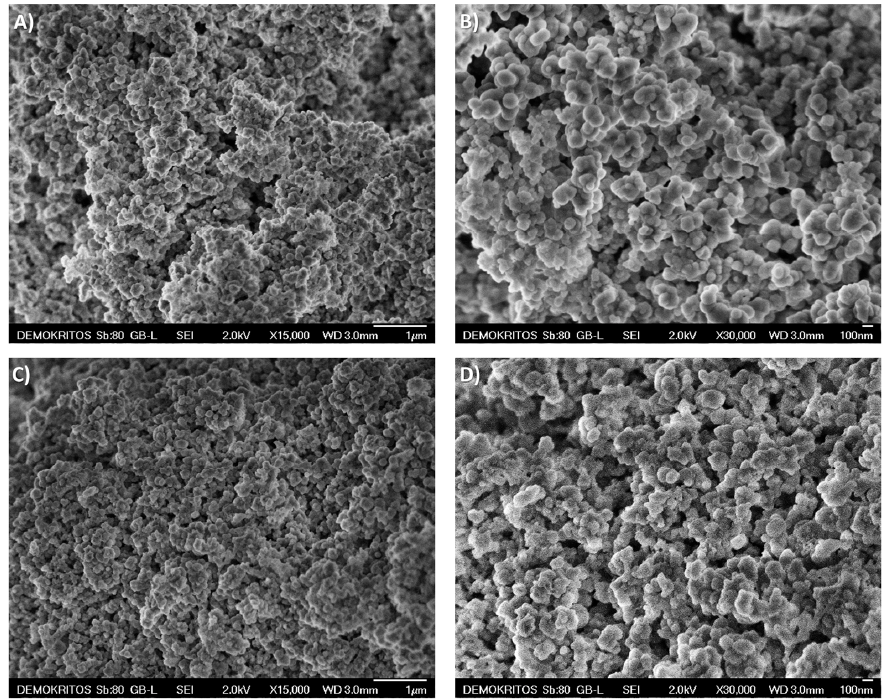
Figure 4. Scanning electron microscopy (SEM) micrographs of samples SiO 2 _PB ( A , B ) and Cu_7.7 wt %_SiO 2 _PB ( C , D